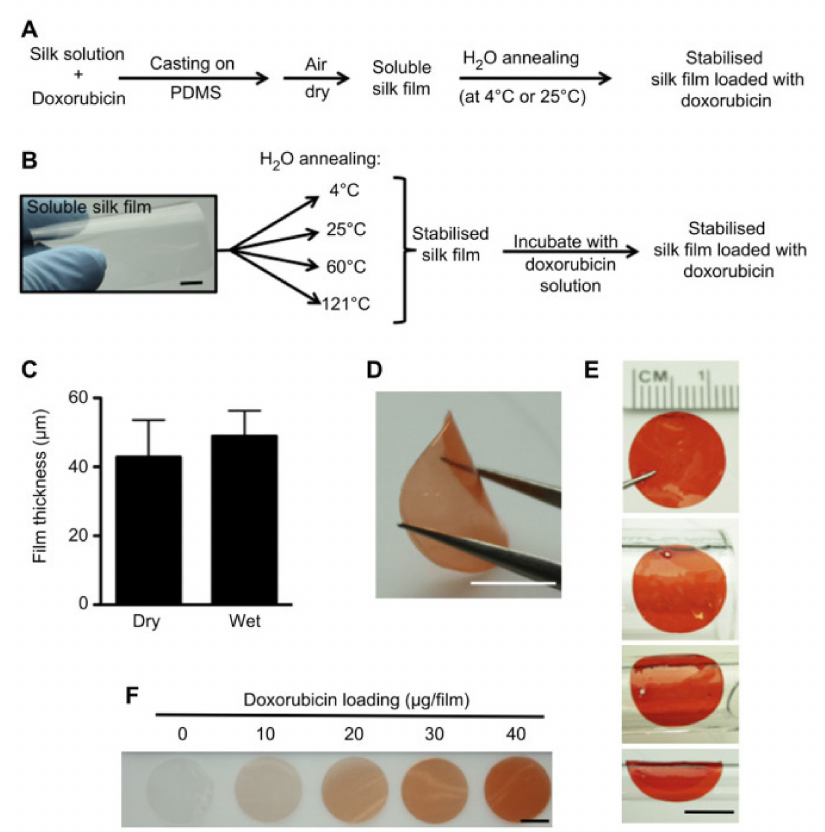
Figure 3. Preparation of doxorubicin (DOX)-loaded silk films. ( A ) Techniques to synthesize DOX- loaded films that are water-soluble or ( B ) water-insoluble with variable beta-sheet content. ( C ) Film thickness of dry and hydrated silk films. ( D ) Doxorubicin-loaded silk films in the dry state (scale bar, 7 mm). ( E ) Hydrated films following surface contours (scale bar, 7 mm). ( F ) Various concentration ranges of DOX loaded in silk films. Reprinted with permission from ref. [58]. Copyright 2012